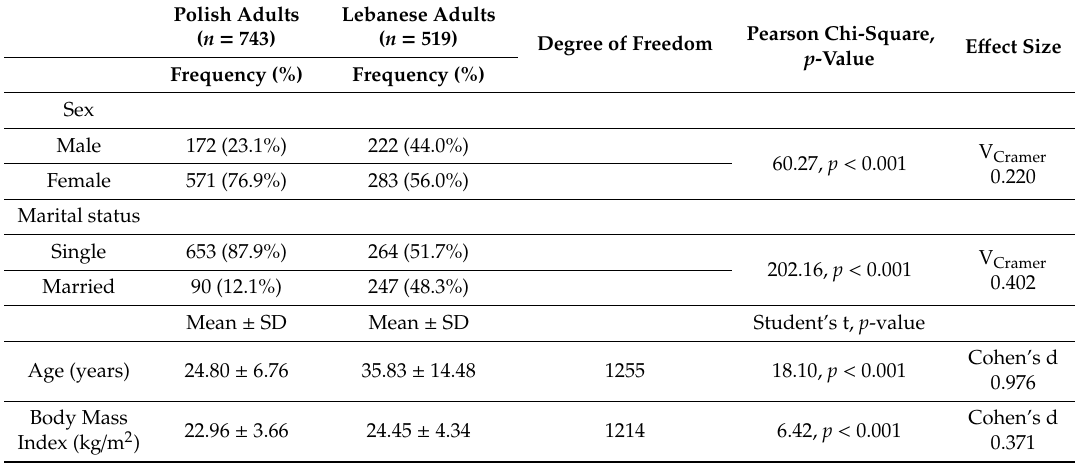
Table 1. Comparison of sociodemographic characteristics in both samples.